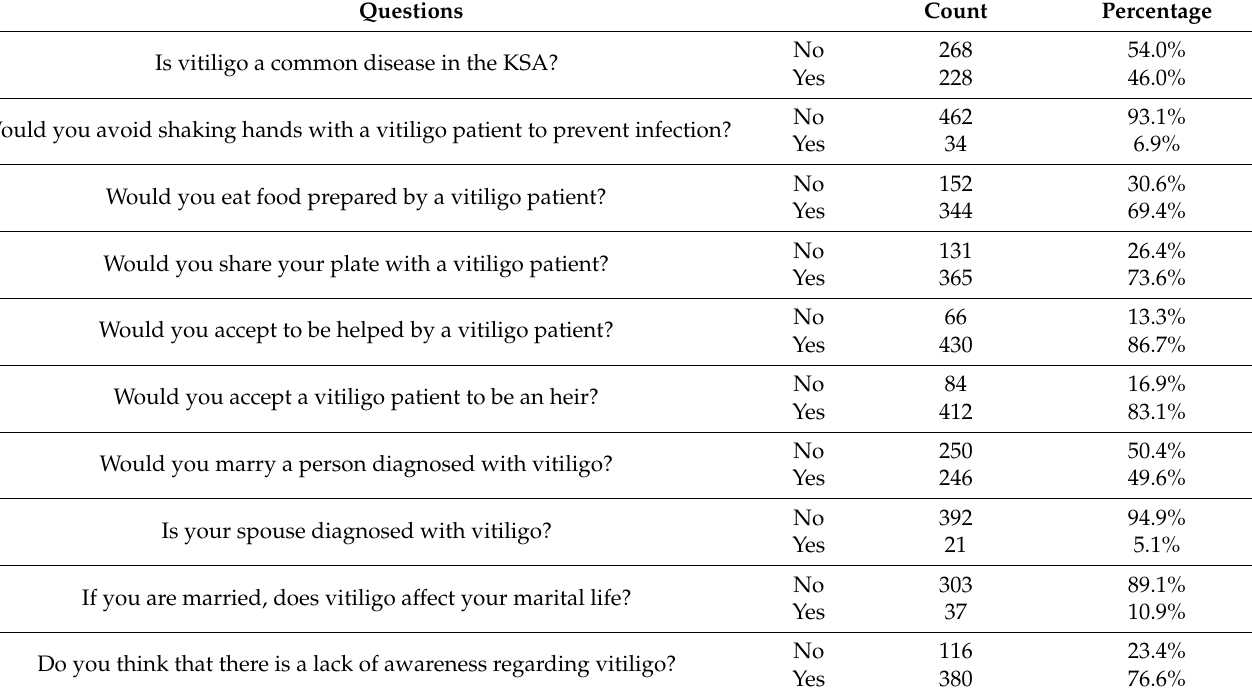
Table 3. Participants’ responses to questions regarding the attitudes toward vitiligo.